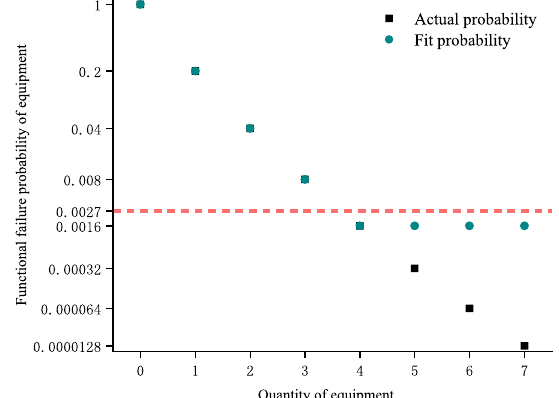
Fig. 2 Schematic diagram of functional failure